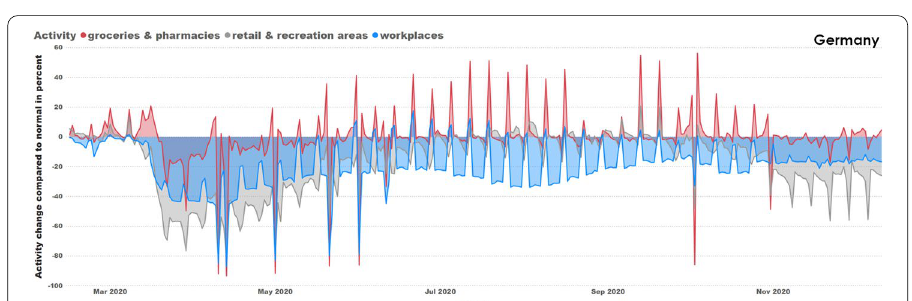
Fig. 14 Minimal but steady reduction of activity